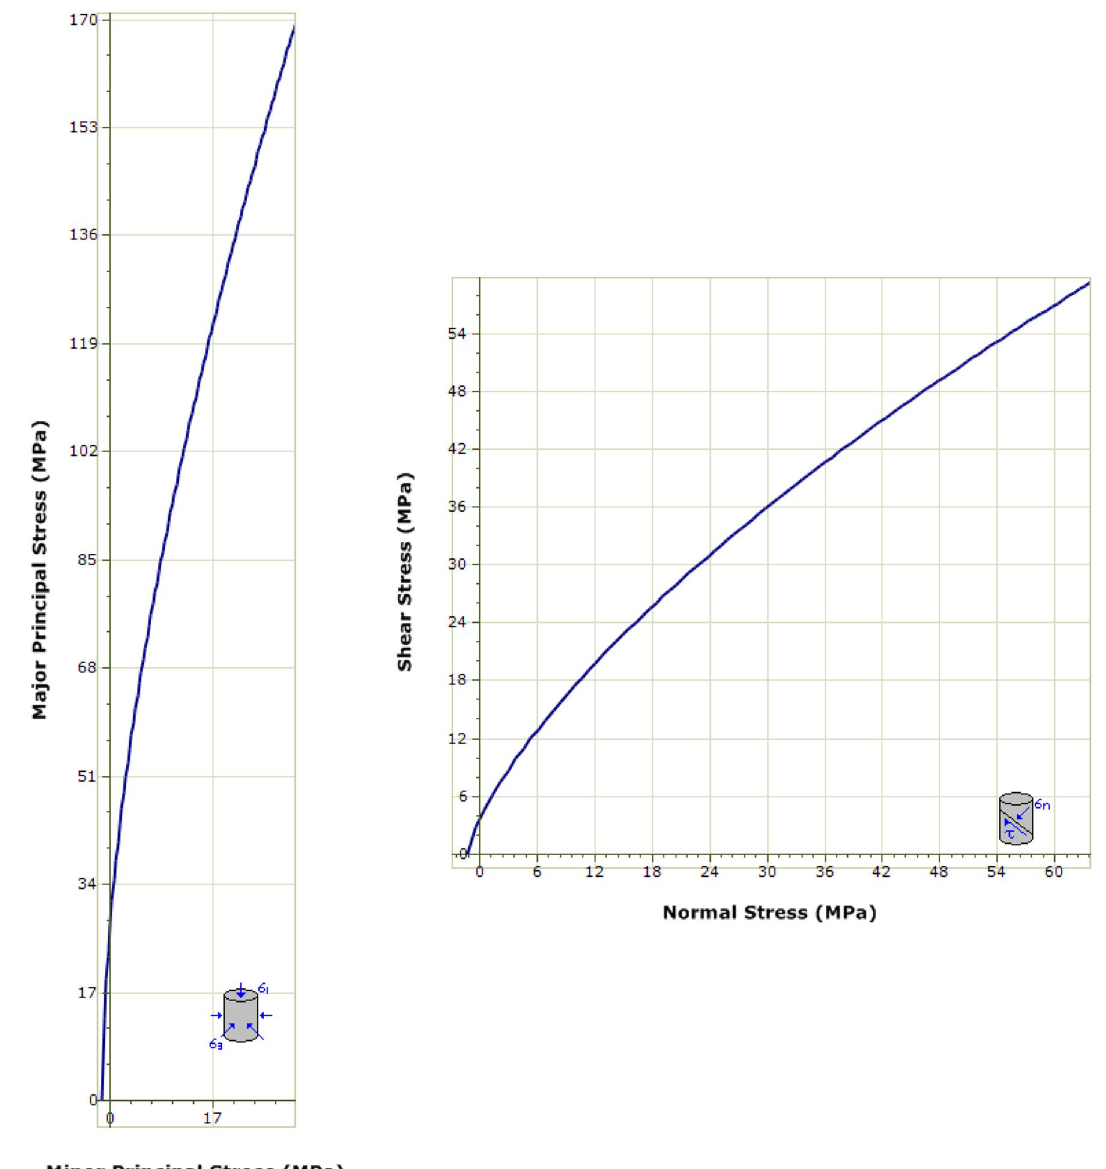
Fig. 12 Hoek–Brown failure envelope and the mean values of geomechanical parameters